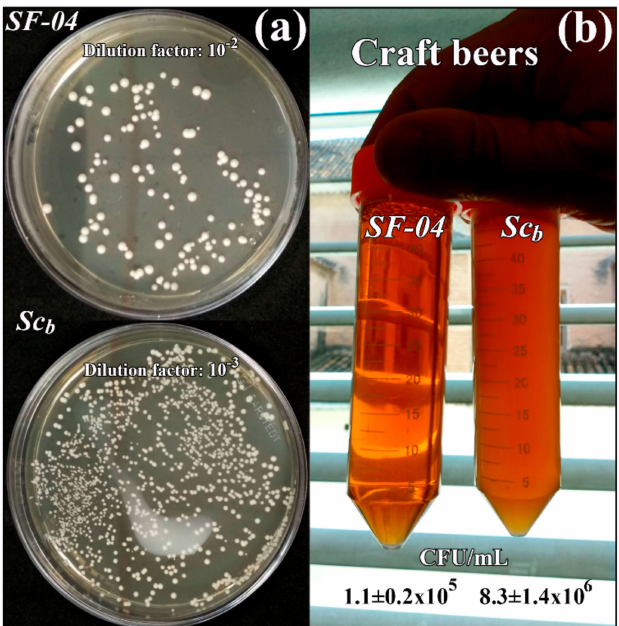
Figure 6. Yeast viability ( a ) of the Saccharomyces cerevisiae var. boulardii ( Sc b ) and Saccharomyces cerevisiae (SF-04) strains in the craft beers ( b ) determined by the colony counting method after 45 days. The number of colonies, which are the number of viable microorganisms (expressed in CFU / mL) in the craft beers and representative plate images of the viable yeast colonies with a dilution factor 10 − 2 and 10 − 3 for SF-04 and S Cb , respectively, are shown.